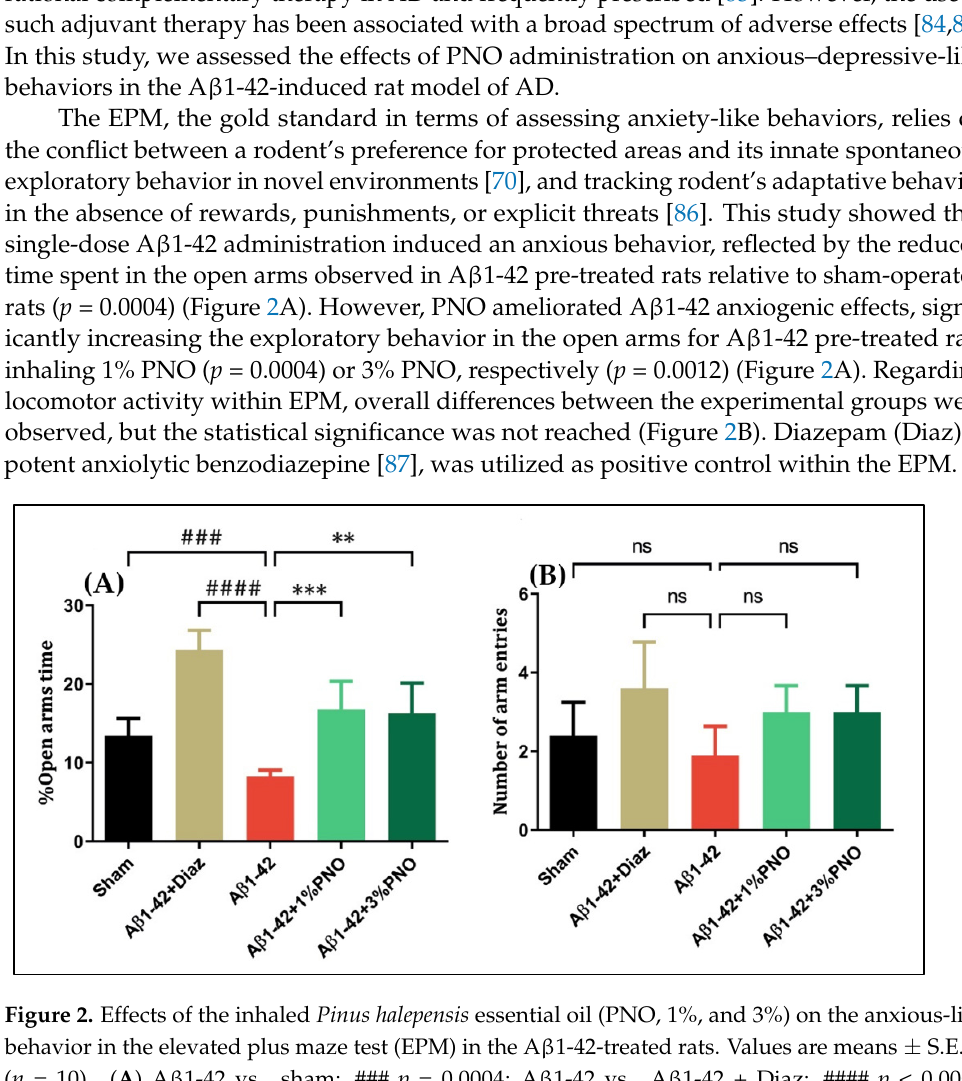
Figure 3. Effects of the inhaled Pinus halepensis essential oil (PNO, 1%, and 3%) on the depressive- like behavior in the forced swimming test (FST) in the A β 1-42-treated rats. Values are means ± S.E.M. ( n = 10). ( A ) A β 1-42 vs. sham: #### p < 0.0001; A β 1-42 vs. A β 1-42 + Imp: #### p < 0.0001; A β 1-42 vs. A β 1-42 + 1% PNO: *** p = 0.0003 and A β 1-42 vs. A β 1-42 + 3% PNO: ** p = 0.0022. ( B ) A β 1-42 vs.